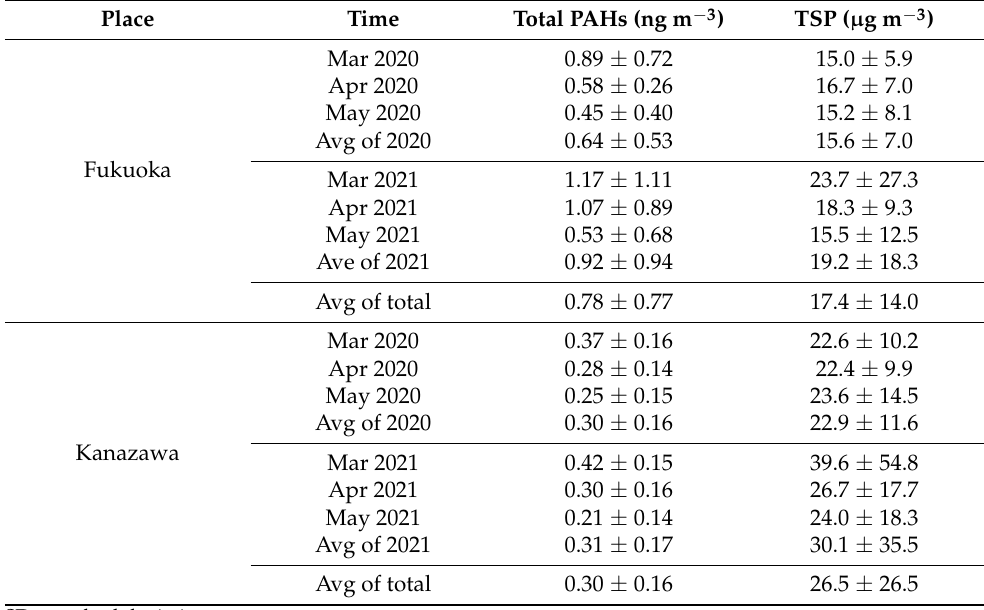
Table 1. Total PAHs (ng m − 3 ) and TSP ( µ g m − 3 ) in Fukuoka and Kanazawa from March to May in 2020 and 2021 (Mean ± SD).